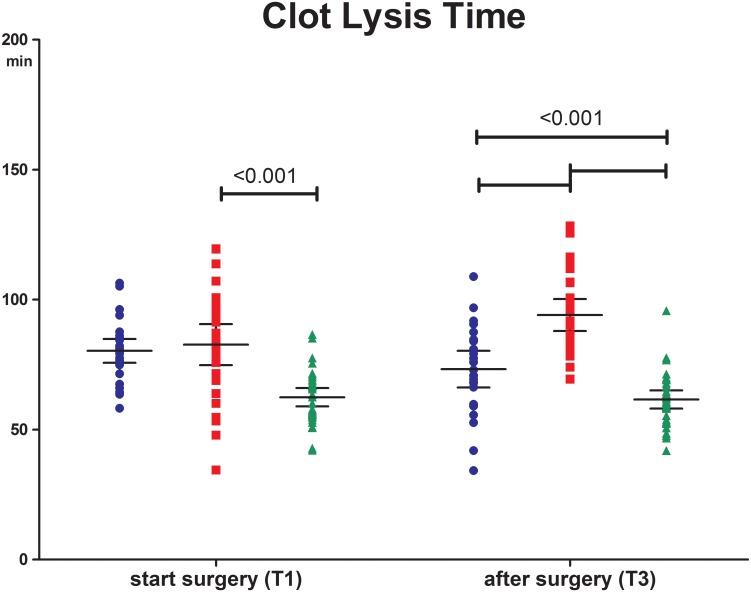
Clot lysis time.Preemptive group (blue triangle), non-preemptive group (red square) and donors (green dot) before incision (T1) and 2 hours after surgery (T3). Data are given as medians with IQR.